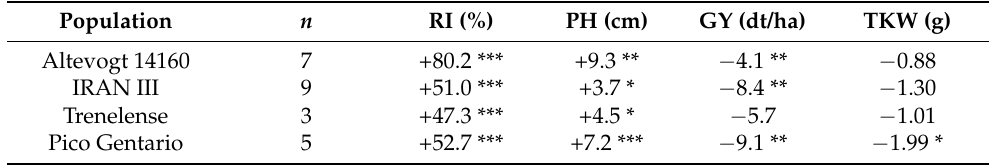
Table 1. Rf effect (=difference between backcross lines with and without Rf gene) for restorer index (RI), plant height (PH), grain yield (GY), and thousand-kernel weight (TKW); n = number of independent